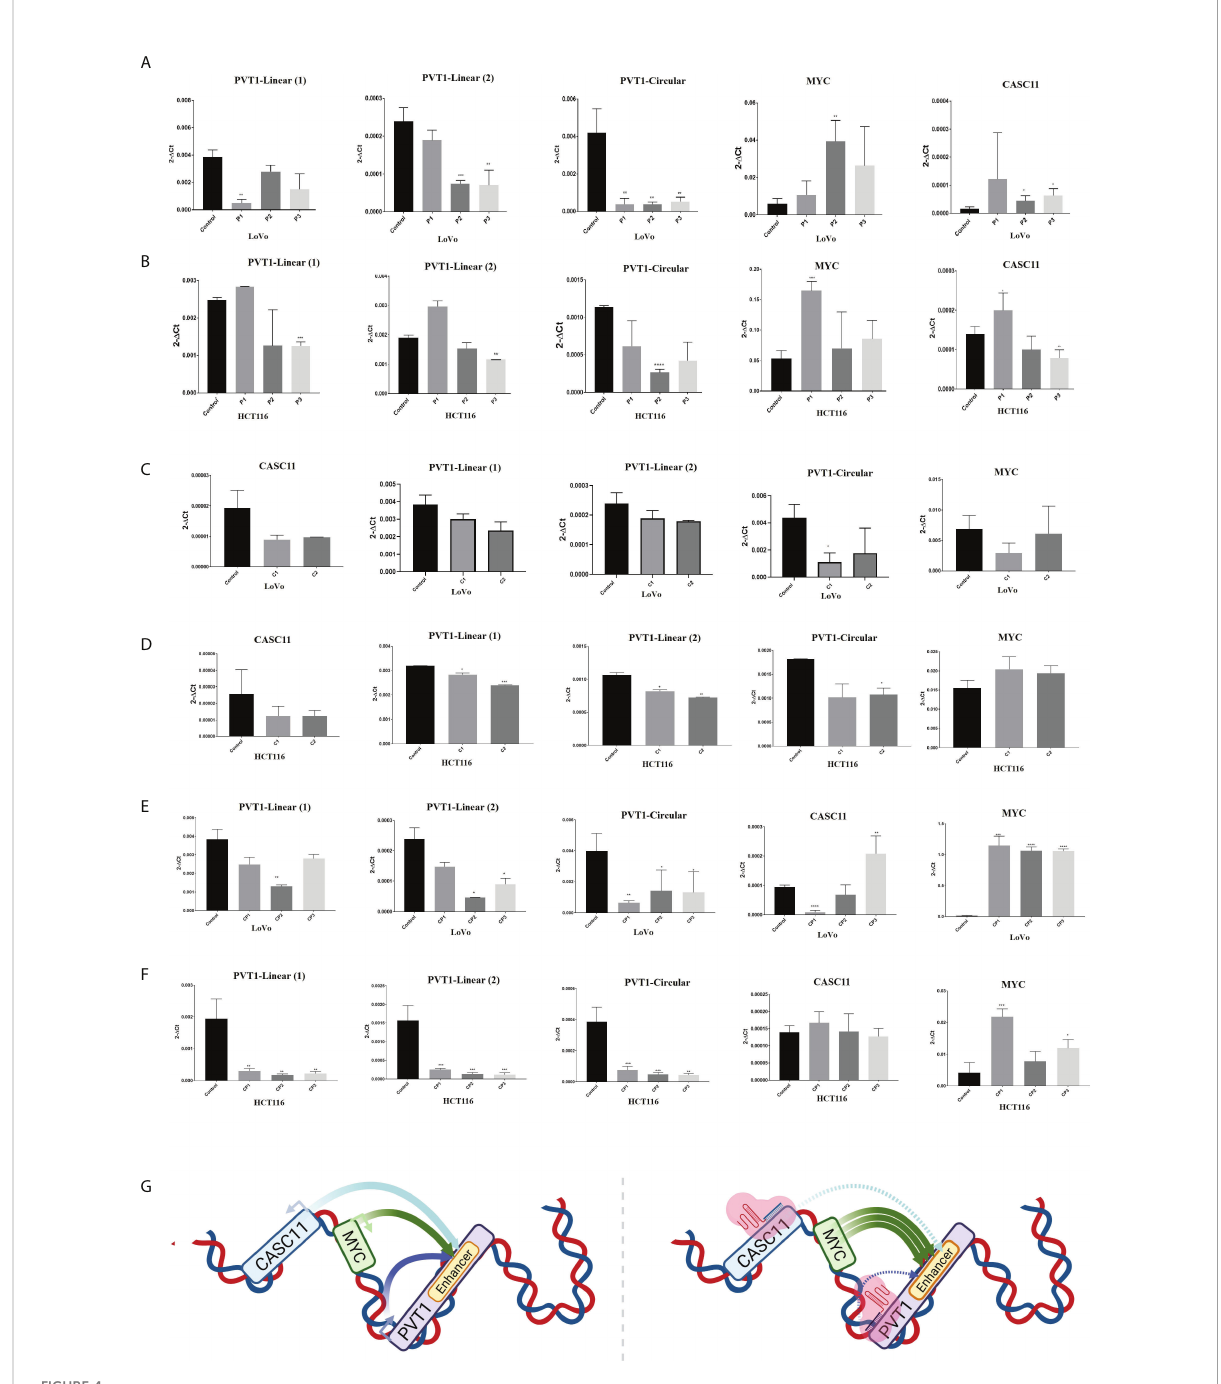
FIGURE 4 PVT1 and CASC11 expression perturbation in LoVo (A) and HCT116 (B) cells. P1: PVT1 sgRNA pair 1, P2: PVT1 sgRNA pair 2, P3: PVT1 sgRNA pair 3, and control: non-targeting sgRNA. PVT1 expression was decreased by using P2 and P3 pair guides. MYC expression was increased after interference with PVT1 expression. Perturbation of CASC11 expression in (C) LoVo and (D) HCT116 cells. C1: CASC11 sgRNA pair 1, C2: CASC11 sgRNA pair 2, and control: non-targeting gRNA. CASC11 expression was decreased by using 2 pair guides. PVT1 expression was slightly decreased after interference with CASC11 expression. Concomitant PVT1-CASC11 perturbation in (E) LoVo and (F) HCT116 cells. CP1: CASC11- PVT1 sgRNA pair 1, CP2: CASC11-PVT1 sgRNA pair 2, CP3: CASC11-PVT1 sgRNA pair 3, and control: non-targeting gRNA. MYC expression was increased by interference with PVT1 and CASC11 expression. (G) Schematic illustration of in cis CASC11/MYC/PVT1 interaction without and with using CRISPRi system. *P<0.05, **P<0.01, ***P<0.001,